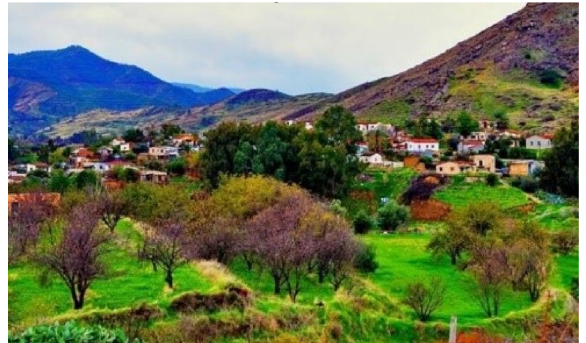
Fig. 1 Ampelikou village. Ampelikou general appearance.